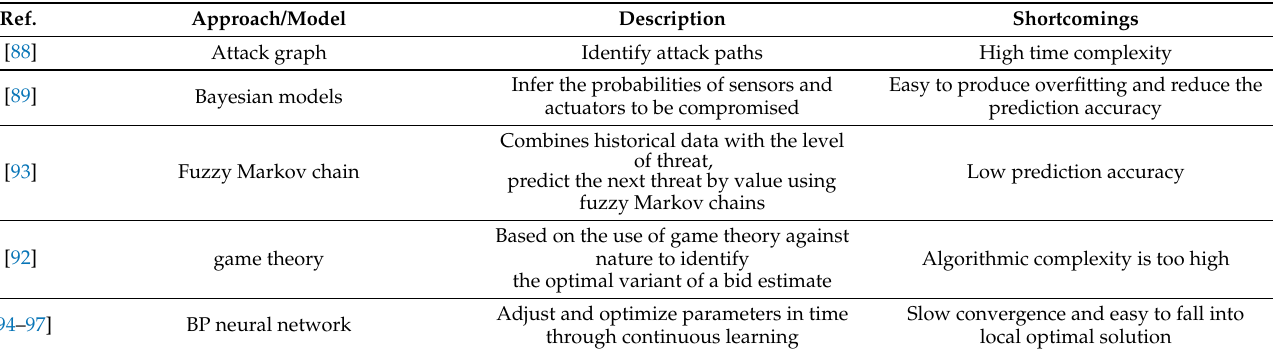
Table 4. Researchers on the network security situation prediction of relevant